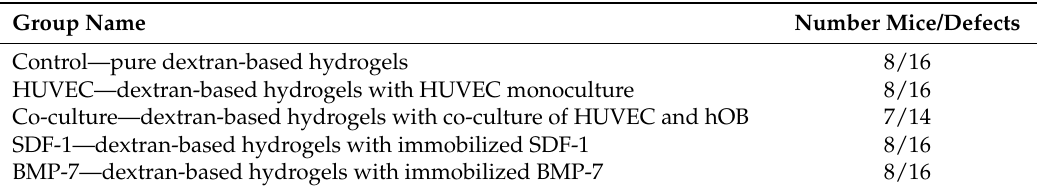
Table 2. One mouse of the group “co-culture” died directly after surgery due to accidental disruption of the dura mater. Table 2. Subdivision of experimental